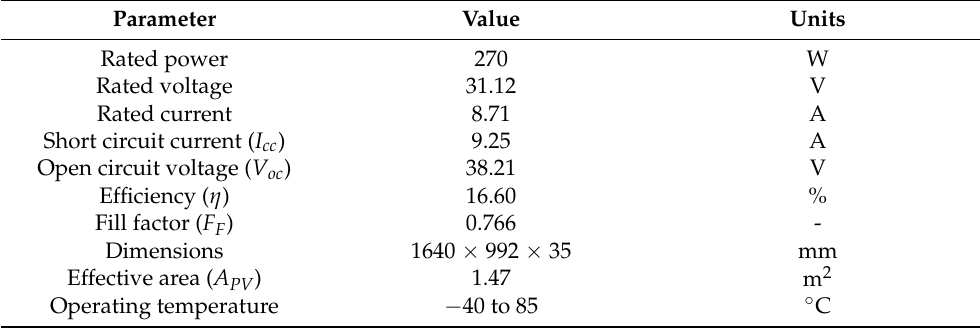
Table 1. Electrical generation properties for the AXITEC AC-270-P modules at standard test conditions.